Question: In one sentence, what is this figure communicating?
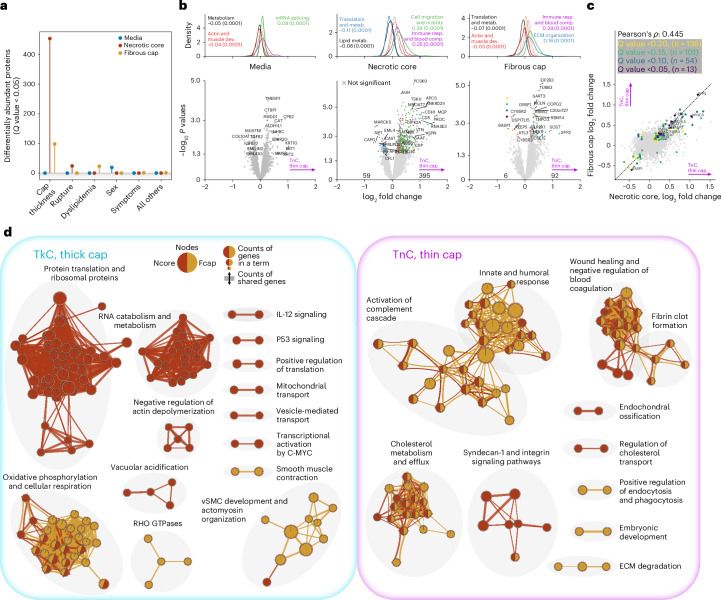
Answer: MCT status is associated with subregion-specific proteomic programs. a , Number of proteins significantly associated with clinical covariates in each plaque subregion ( q < 0.05; moderated t -test). b , Protein abundance differences by MCT status within each plaque subregion (media, necrotic core and fibrous cap). Upper panels show distributions of log 2 fold changes (TnC versus TkC) for proteins assigned to each MG, with median fold changes and bootstrap-derived P values indicated. Lower panels show protein-level differential abundance; numbers indicate significantly different proteins (two-sided bootstrap test, q < 0.05). Points are colored by MG. c , Concordance of MCT-associated protein abundance changes between the necrotic core and fibrous cap, shown as log 2 fold changes (TnC versus TkC) in each subregion (Pearson’s ρ = 0.445). Proteins are colored based on statistical confidence ( q -value thresholds). d , Network representation of enriched biological processes among proteins associated with MCT plaque phenotypes, showing distinct pathway enrichment patterns in TkC (left) and TnC (right) plaques. Nodes represent enriched terms, with size proportional to the number of proteins per term and pie charts indicating subregional contribution; edges connect related terms on the basis of shared proteins. Source data